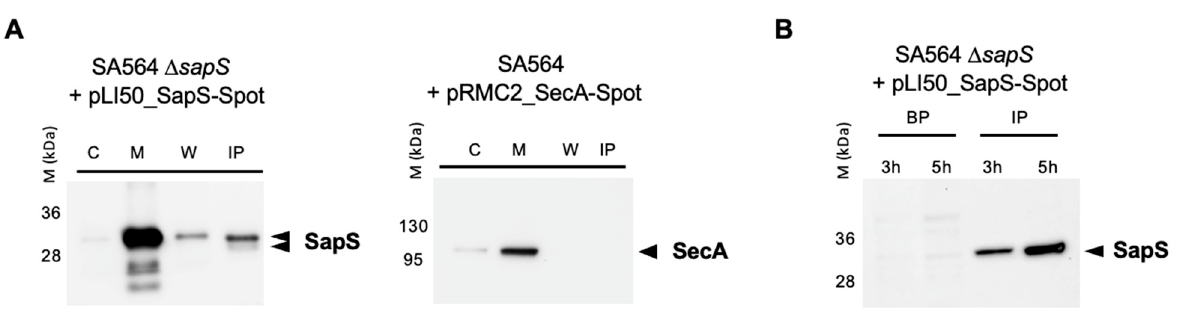
Figure 2. SapS is produced by S. aureus both in vitro and in infected macrophages. ( A ) Cultures were grown up to exponential phase and supernatants from SA564 ∆ sapS + pLI50_SapS-Spot and SA564 + pLI50_SecA-Spot (negative secretion control) were filtered and immunoprecipitated using anti-Spot magnetic beads, while bacterial pellets were resuspended and lysed in PBS with lysostaphin, a protease inhibitor cocktail, DNAase I and fractionated. Cytoplasm (C), membrane (M), cell wall (W), and immunoprecipitated proteins (IP) from supernatants were migrated on SDS-PAGEs, transferred to PVDF membranes for Western-blot analyses using monoclonal mouse anti-Spot antibody as primary antibody (Chromotek, Germany) and an HRP-coupled donkey-anti-mouse antibody as secondary antibody (Jackson Immuno Research). Data are representative of three different experiments. ( B ) RAW 264.7 macrophages (2.5 × 10 5 cells/well) were infected with S. aureus at a MOI of 20, and non-phagocytosed bacteria were subsequently removed by gentamicin/lysostaphin treatment. Infected macrophages were lysed in 0.1% Triton X-100 and centrifuged at 14,000× g . The macrophage lysates were immunoprecipitated with anti-Spot magnetic beads (Chromotek), while the pellets of the intracellular bacteria were resuspended in an equal volume of lysis buffer. Immunoprecipitated proteins (IP) and bacterial pellets (BP) were separated on SDS-PAGE and observed with an anti- Spot antibody as described in ( A ). Data are representative of three different experiments (M kDa: molecular